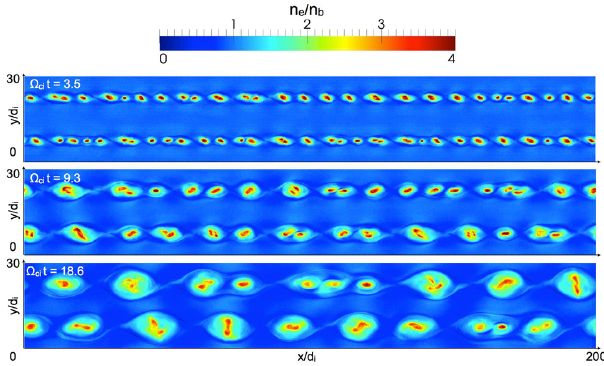
Fig. 2. Contour plots of the electron density, normalized to the back- ground density n b , at different times. The plot shows the formation and the progressive growth of relatively high density regions, the plasmoids, by